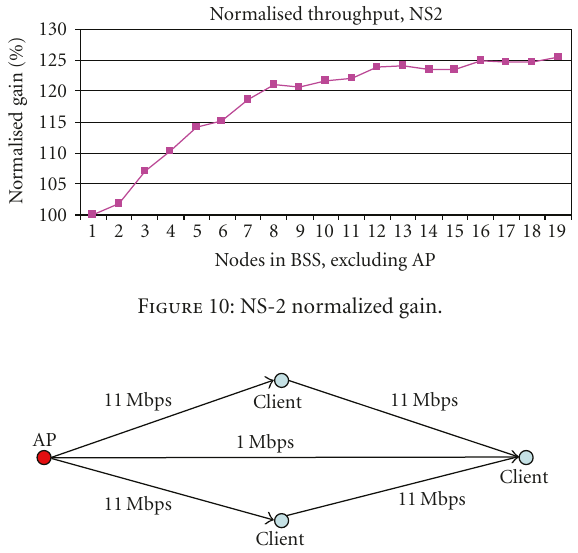
Figure 11: Ideal scenario for NS2 simulation.